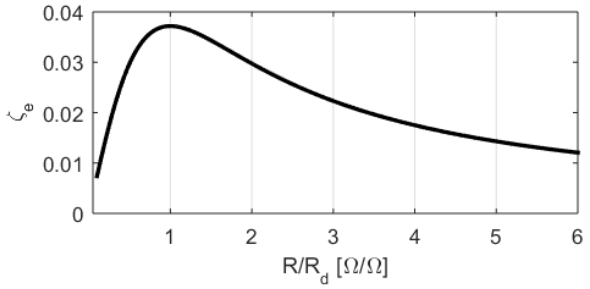
Figure 2. The impact of the applied load R normalized to R d on the electrical damping ratio ζ e.